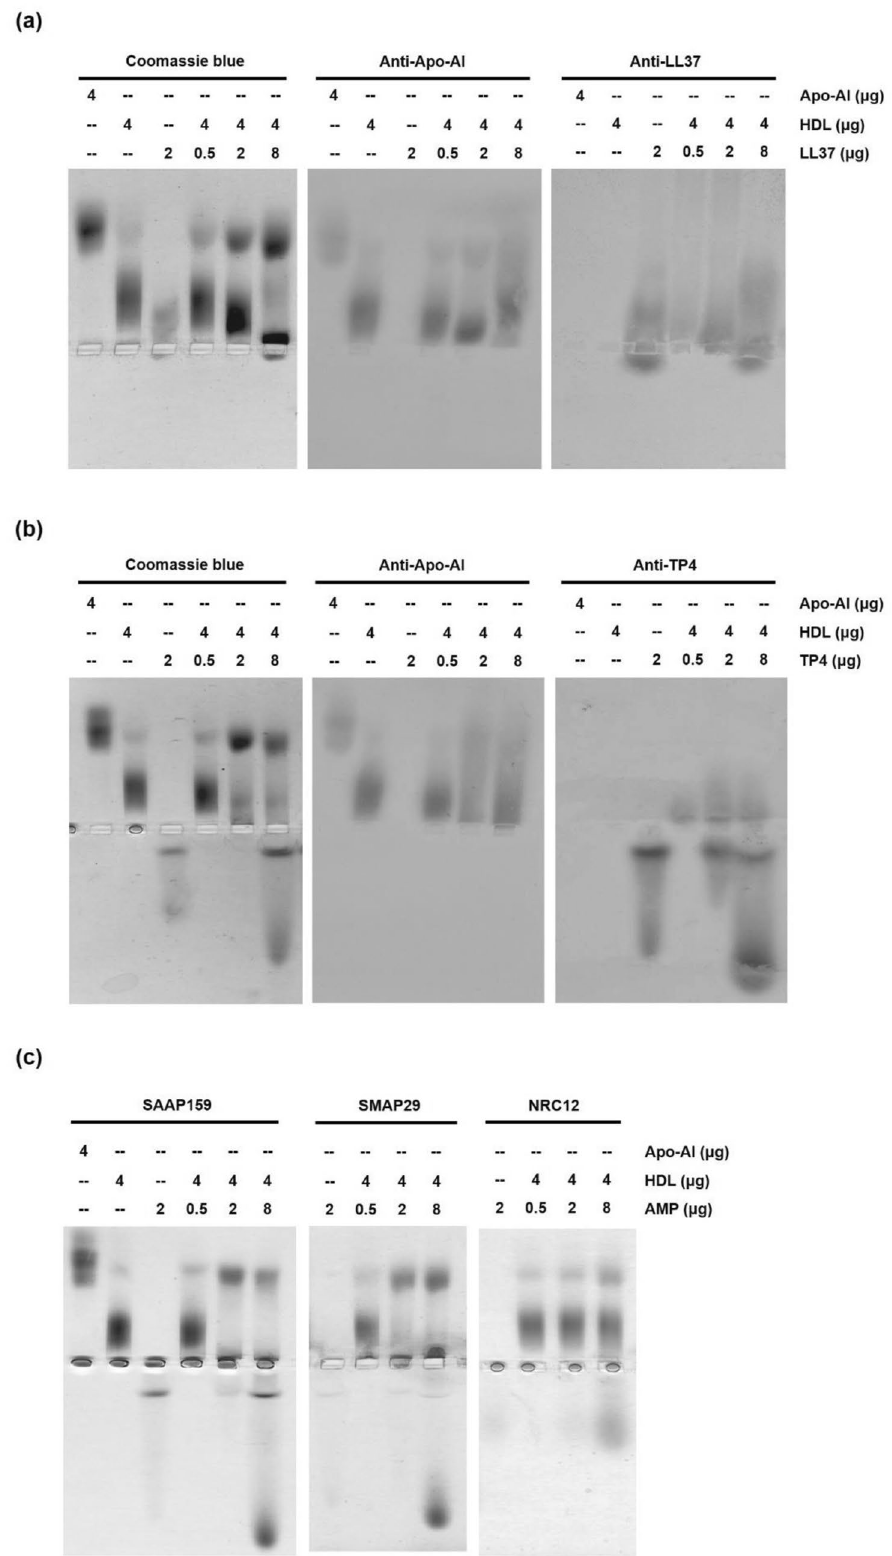
Figure 5. Destructive effect of AMP on HDL ( a, b ) Band shift of HDL cause by TP4 ( a ) or LL37 ( b ) analyzed by 8% horizontal native PAGE, pH8.8, followed by Coomassie blue staining (left) and Western blotting using anti- Apo-AI (middle) and anti-AMP (right) antibodies. ( c ) Band shift of HDL cause by SAAP159 (left), SMAP29 (middle) and NRC12 (right) analyzed by 8% horizontal native PAGE, pH8.8, and Coomassie blue